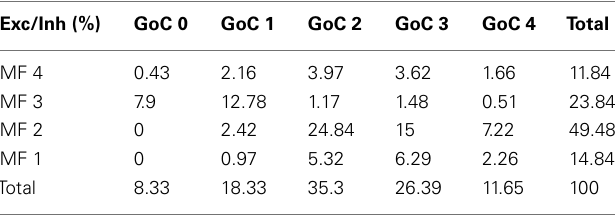
Table 1 | Cross-table of excitatory and inhibitory inputs to a granule